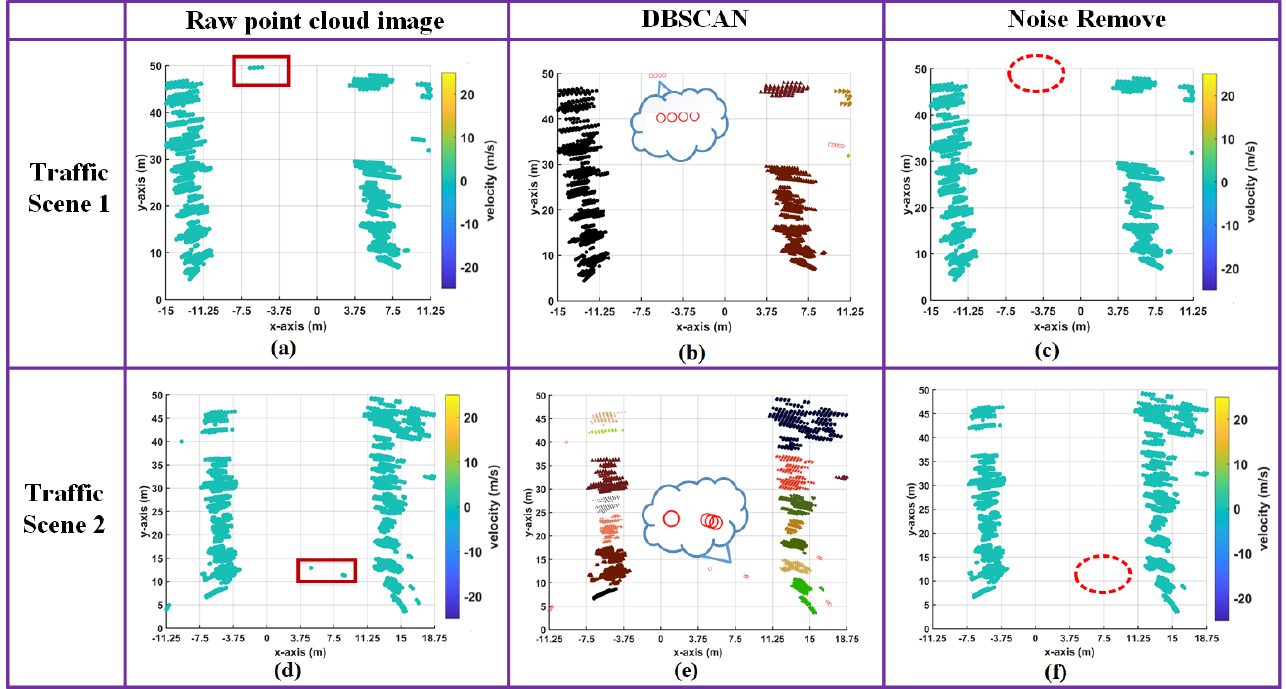
Figure 26. Noise points removal results by DBSCAN algorithm. ( a ) Raw point cloud image of traffic scene 1. ( b ) Target point classification by the DBSCAN in traffic scene 1. ( c ) Noise remove Result in traffic scene 1. ( d ) Raw point cloud image of traffic scene 2. ( e ) Target point classification by the DBSCAN in traffic scene 2. ( f ) Noise remove Result in traffic scene